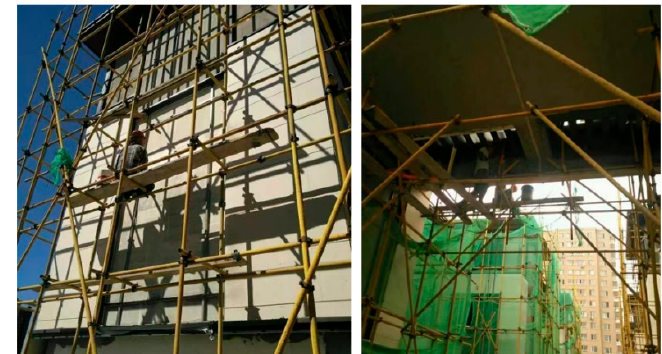
Figure 12. The installation process of insulation boards.